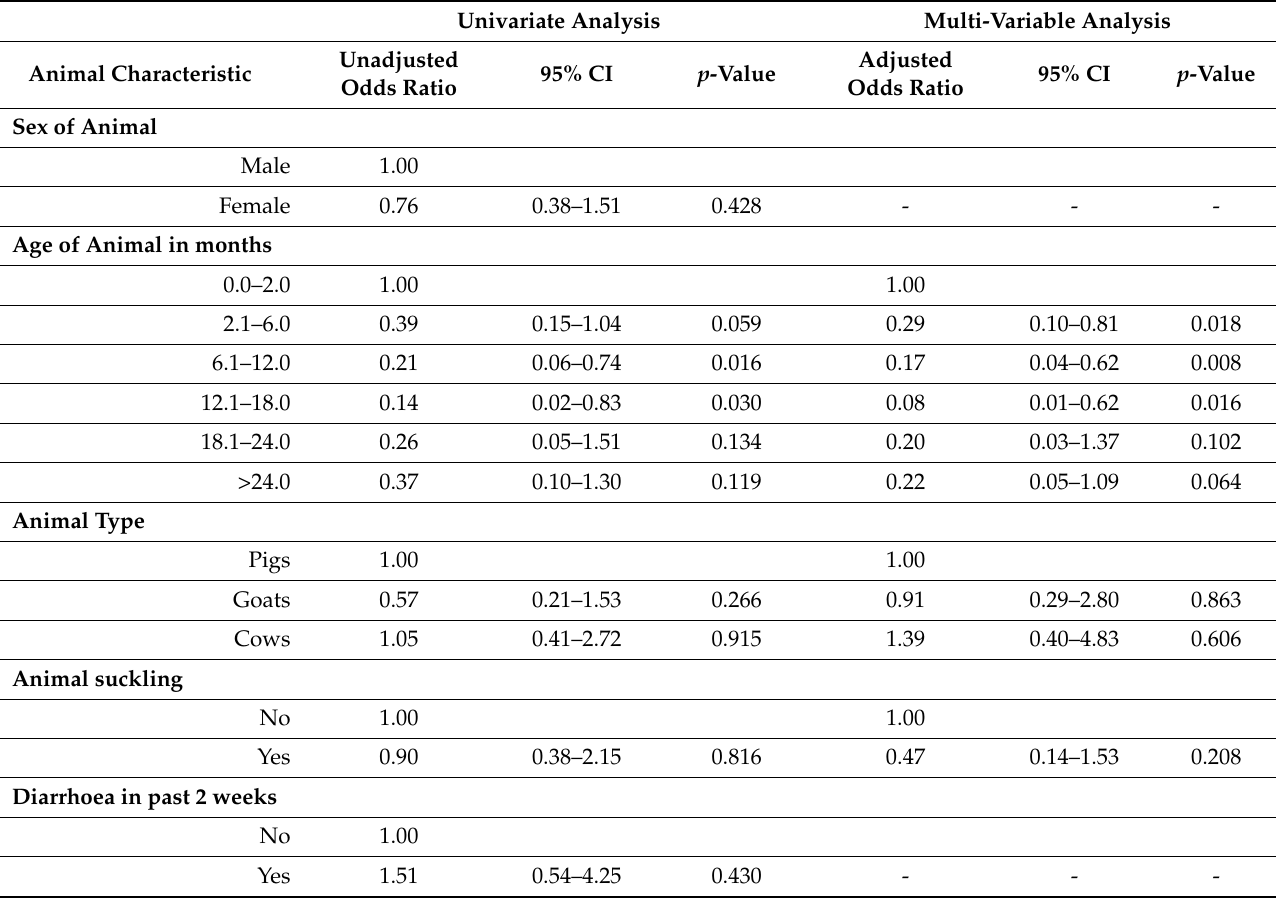
Table 2. Univariate and multi-variable analysis of factors independently associated with Rotavirus infection in domestic animals in Masaka District, Central Uganda,